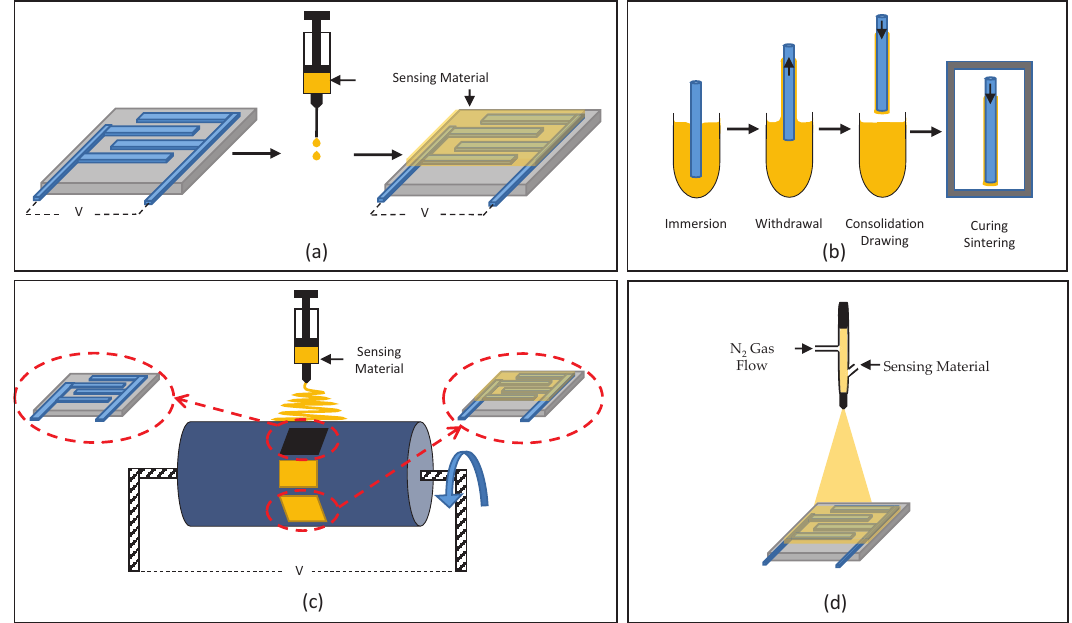
Figure 1. Schematic illustration of deposition methods: ( a ) drop-coating, ( b ) dip-coating, ( c ) electro-spinning and ( d )